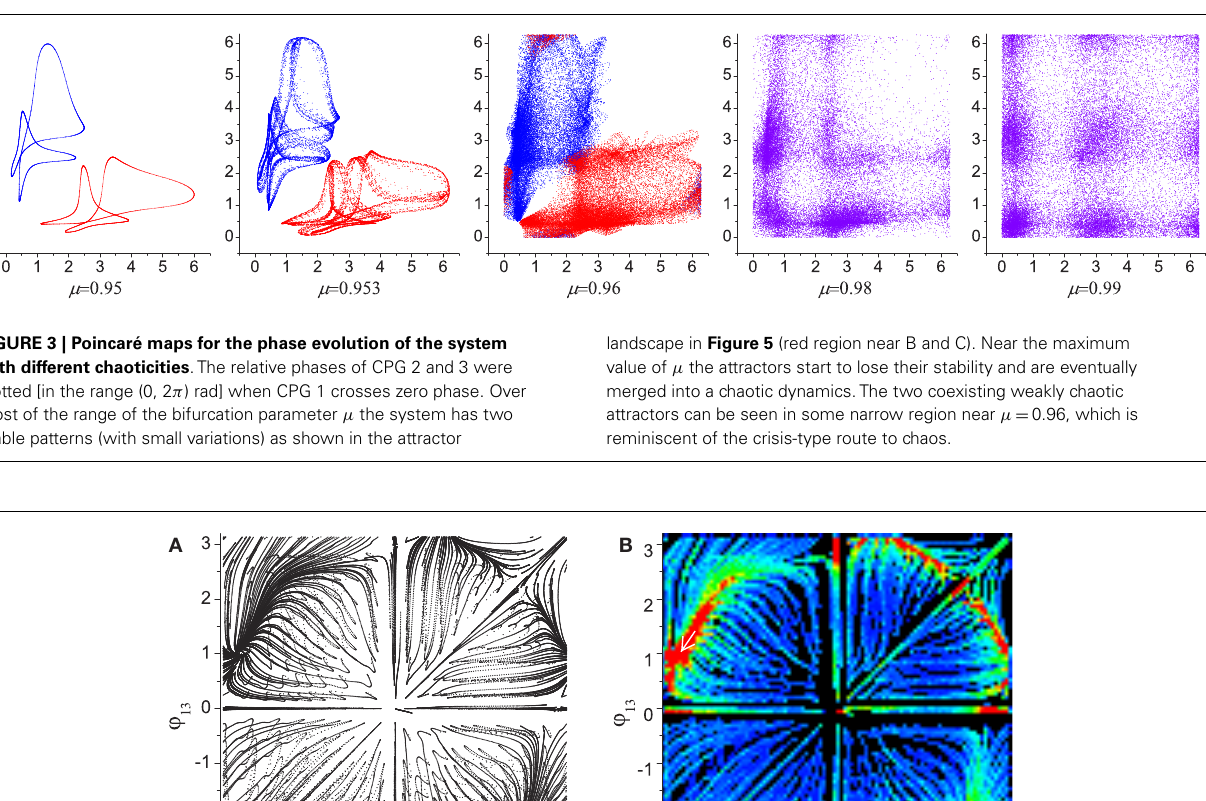
further details. (B) Stability landscapes (2D histogram) for same: pixel colors represent the density of pattern appearance (visit duration). Colors are coded from blue (low density) to red (high), and black represents zero appearance due to the limited simulation time and the finite number of initial